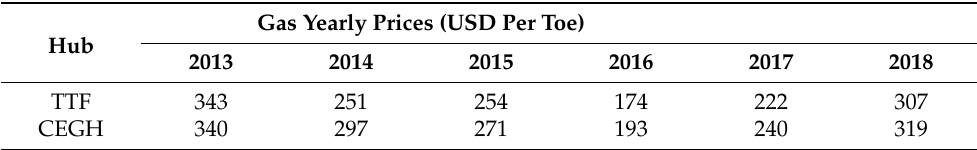
Table 7. Parametric method—yearly gas price results (in USD per tons of oil equivalent).